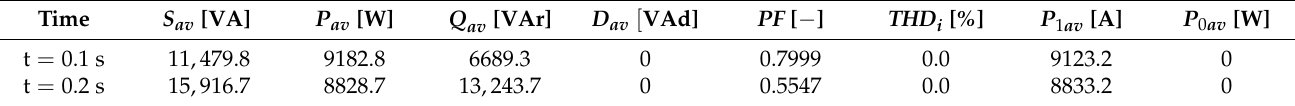
Power component average values, computed in Matlab/Simulink are given in Table 11. Table 11. Simulation results before and after the change (at steady states). Table 11. Simulation results before and after the change (at steady states).